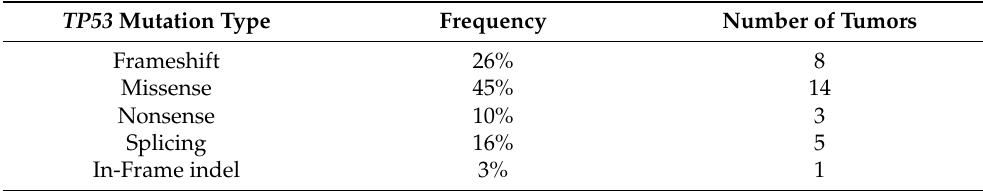
Table 1. Description and frequency of TP53 mutations in New Zealand breast cancer